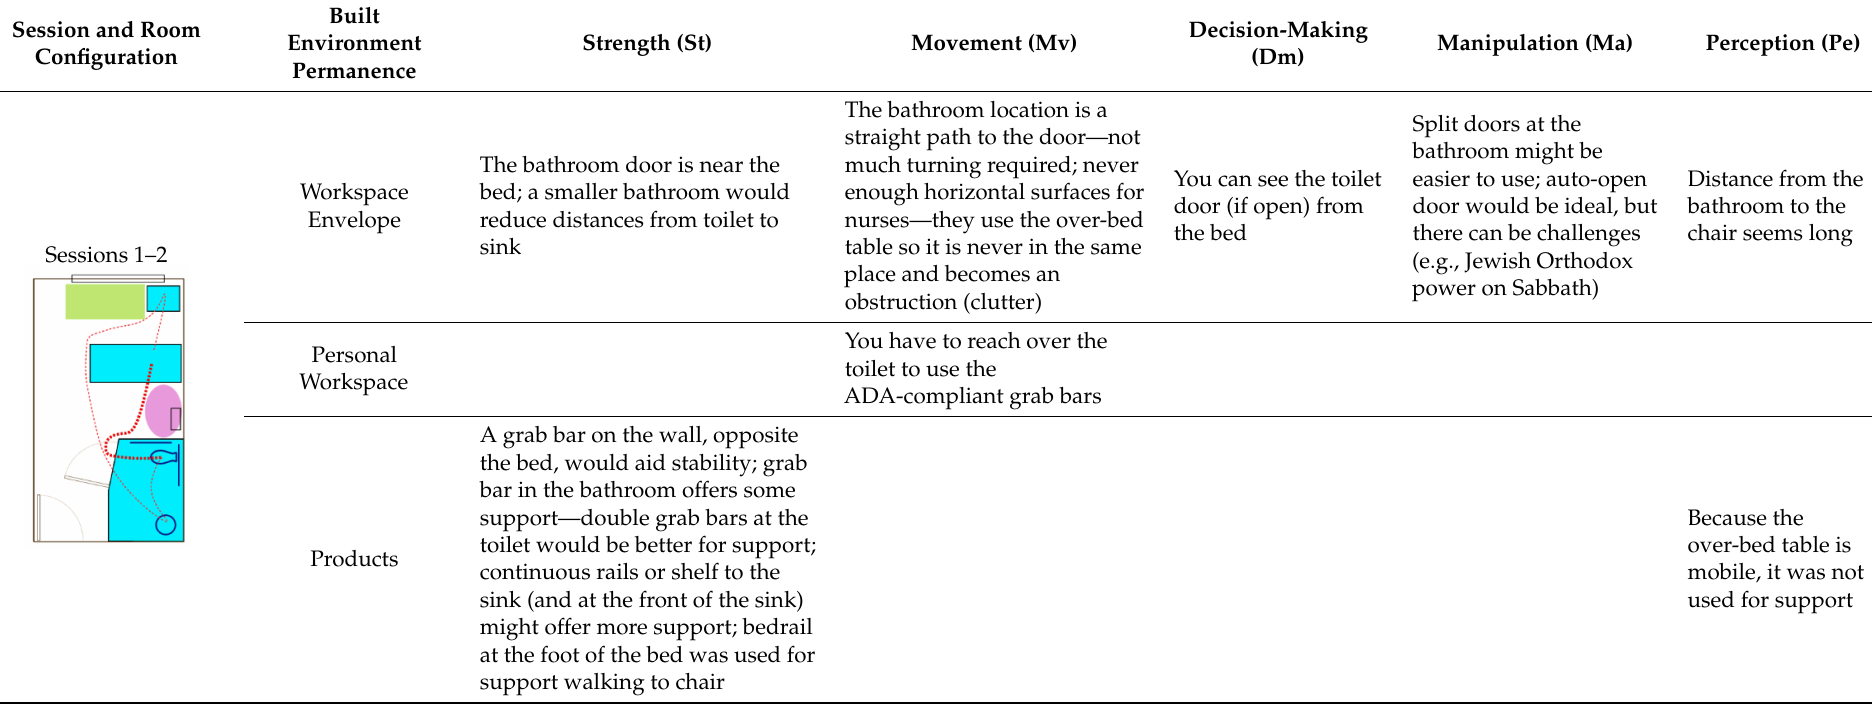
Table 2. Session 1–2 feedback (Room 1—inboard corner